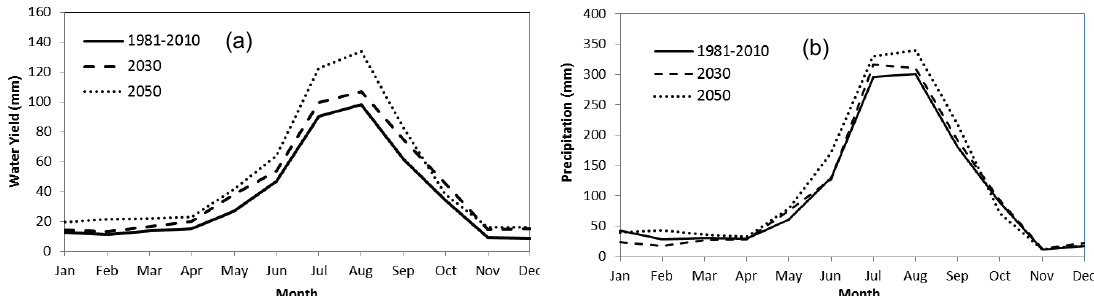
Fig 3 Monthly variations of precipitation and water yield for the three time